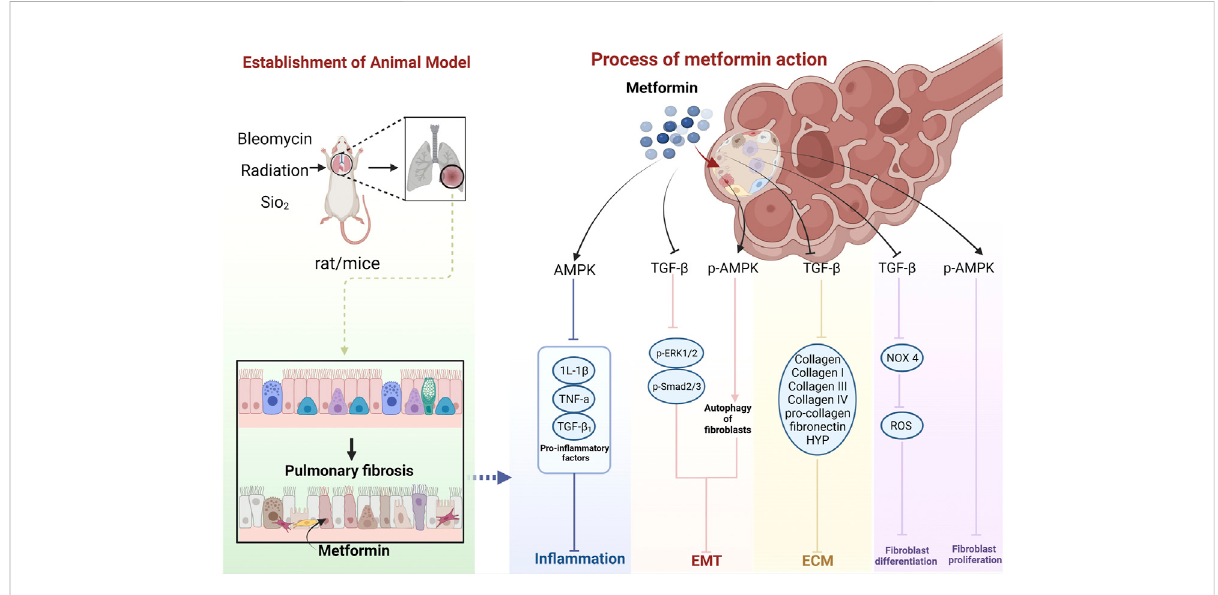
FIGURE 14 Schematic representation of the possible molecular mechanism of MET inhibition of PF. (Created using